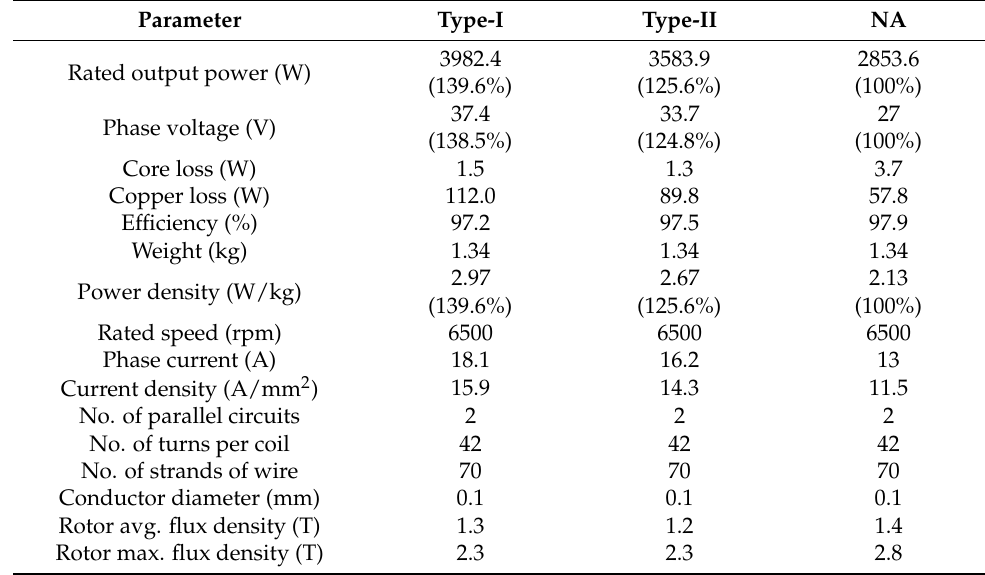
Table 3. Comparison of the analysis results for the three rotor